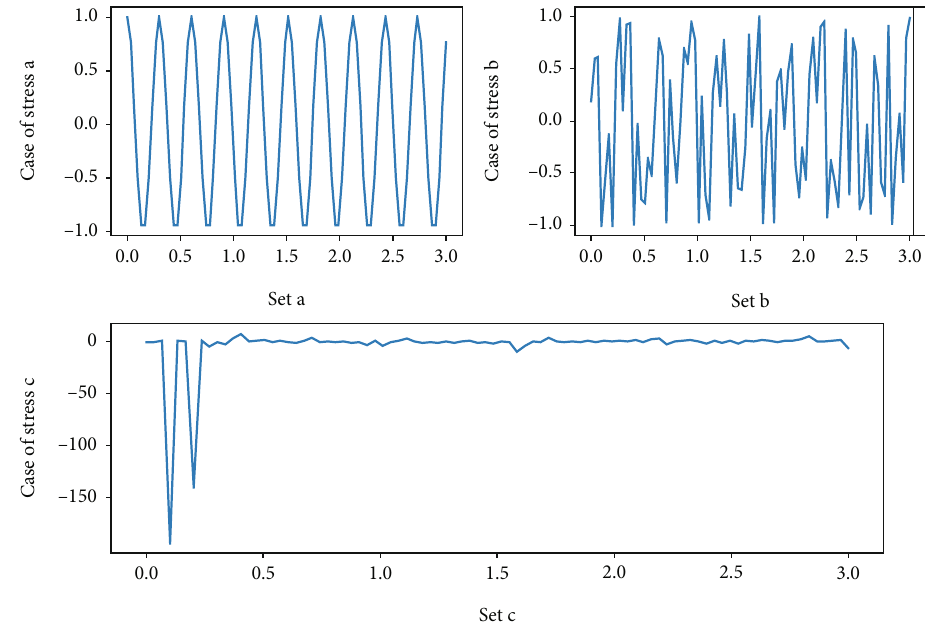
Figure 4: Distribution of reliability coe ffi cients of emotional stress hypothesis.